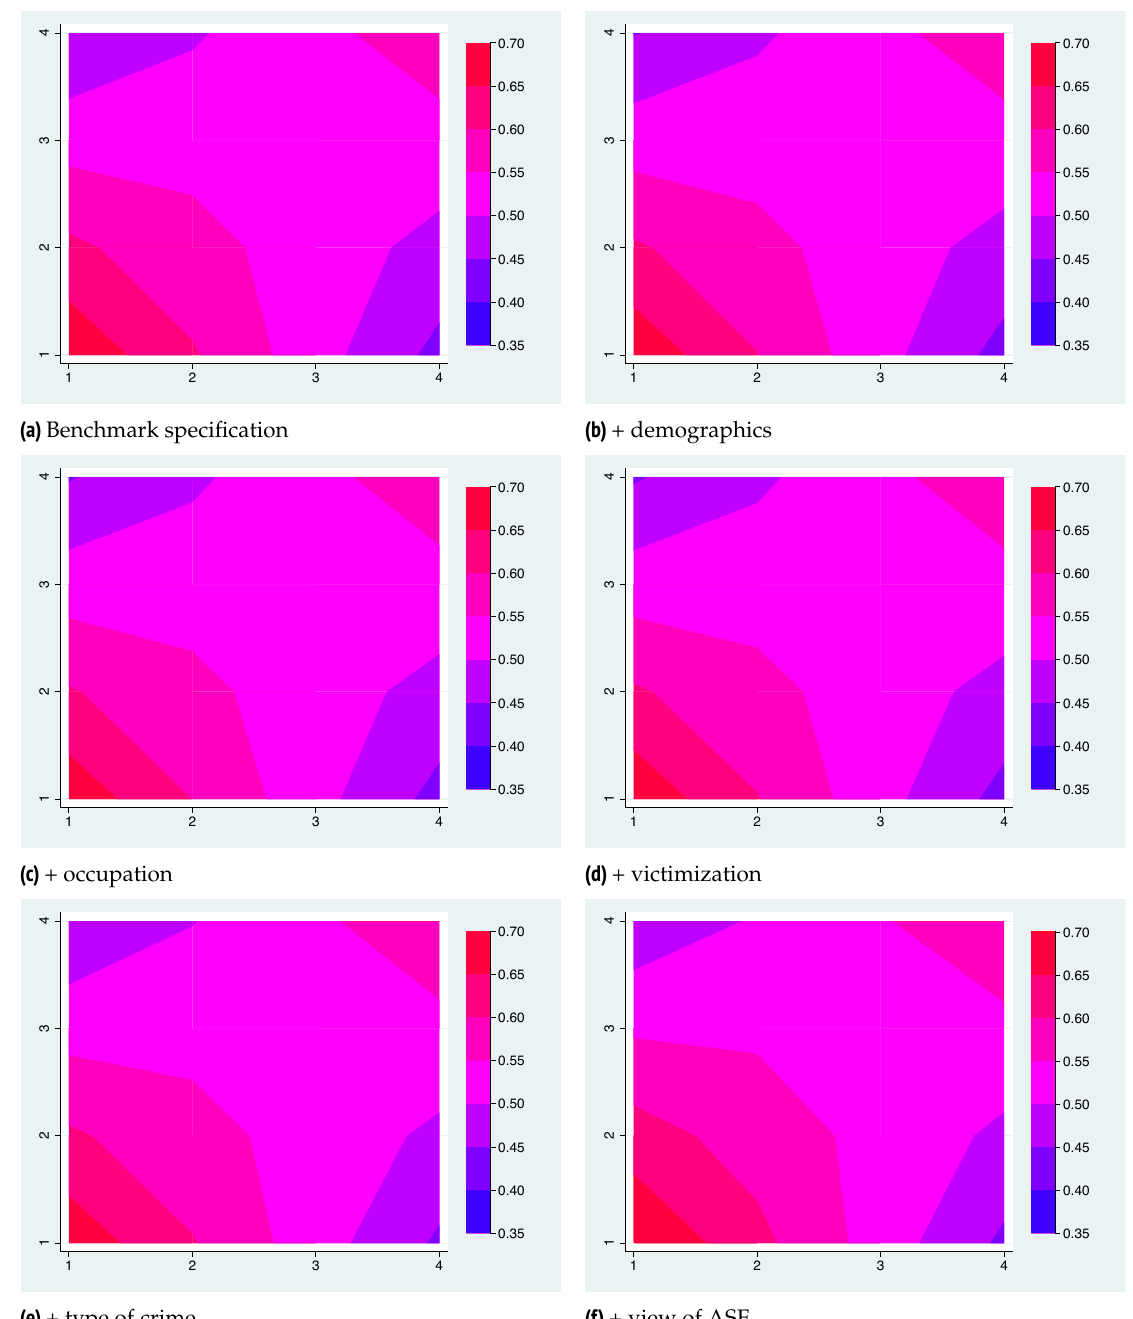
Figure 2: Impact of individual and village views of the Taliban on willingness to report wrongdoing. Notes: Figure displays fitted values obtained from main regression specification (with additional parameters as noted). For interpretation, we focus on the corner of each quadrant. Bottom left (1,1) indicates internal alignment; upper right (4,4) indicates external alignment; off-diagonal corners (upper left, bottom right) indicate misalignment. Models are cumulative based on alphabetical sequence. ASF indicates Afghan Security Forces, which includes separate parameters for respondent attitudes toward the Afghan National Army, the Afghan National Police, and the local police. sociological science |